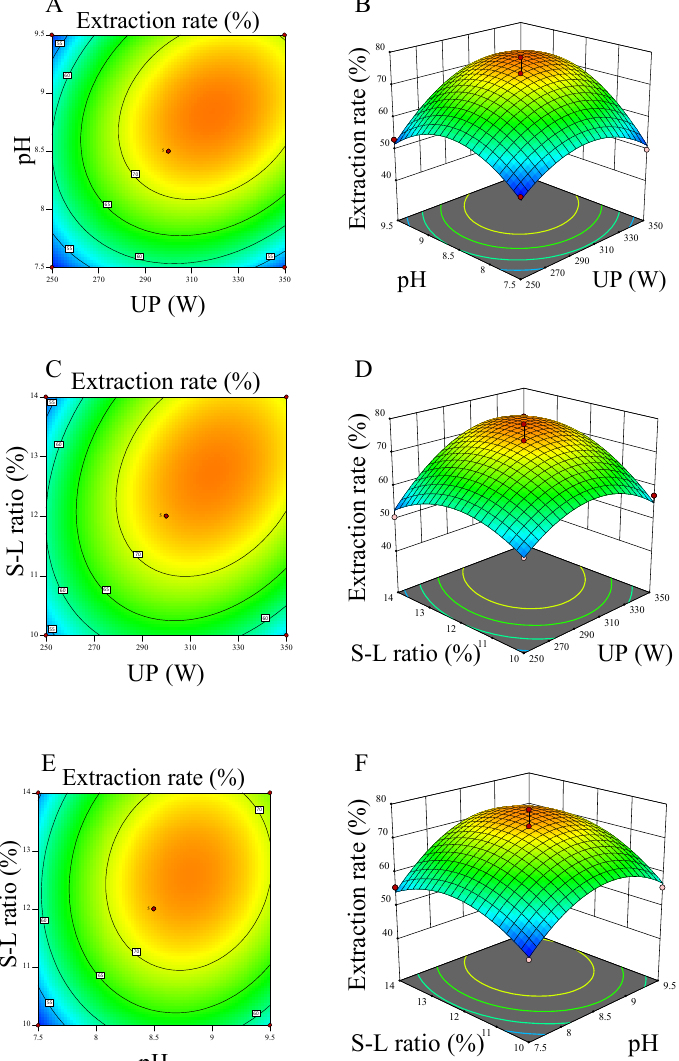
Figure 2. Response surface plots showing the effects of extraction pH, UP (ultrasound power) and solid-liquid (S-L) ratio on the WBY protein extraction. ( A , B ) effect of interaction between extraction pH and UP; ( C , D ) effect of interaction between UP and S-L ratio; ( E , F ) effect of interaction between the extraction pH and S-L ratio.